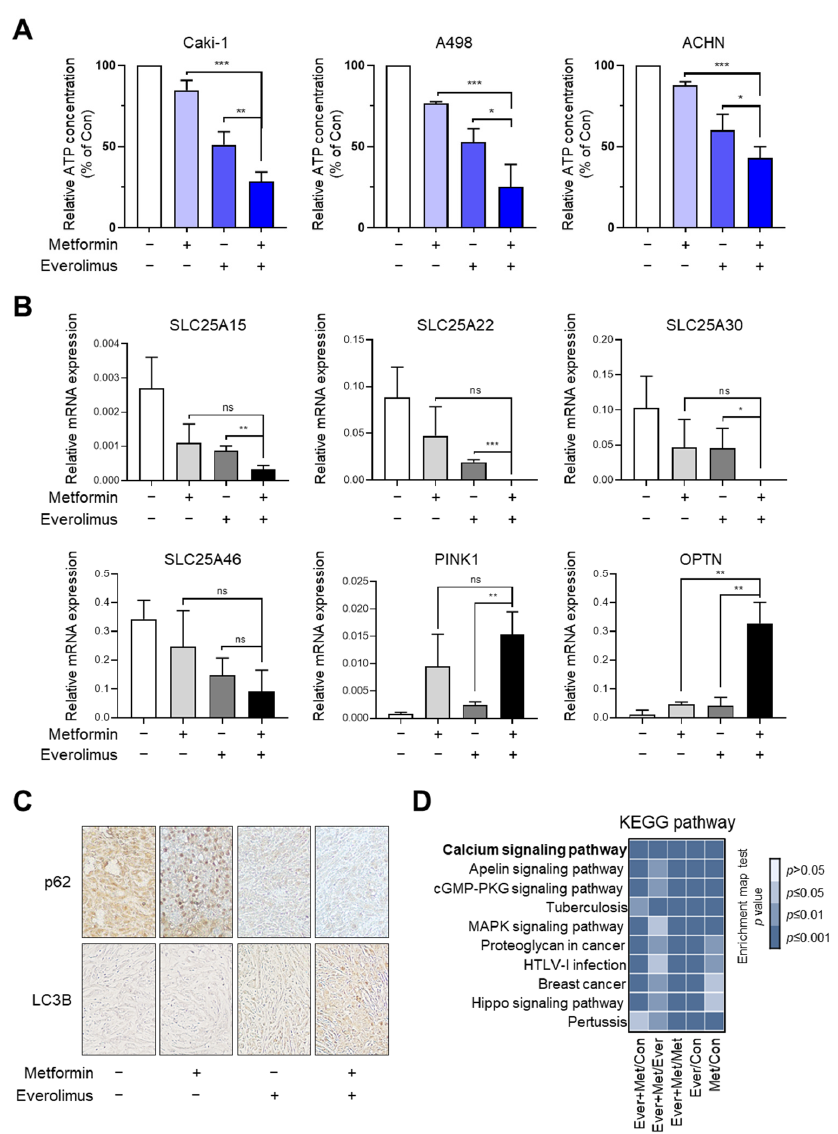
Figure 5. Combination treatment of metformin and everolimus synergistically reduces RCC growth by disrupting mitochondrial function: ( A ) Relative ATP concentration in Caki-1, A498, and ACHN xenografts treated with the control, metformin, everolimus, and combination of the drugs; ( B ) qRT-